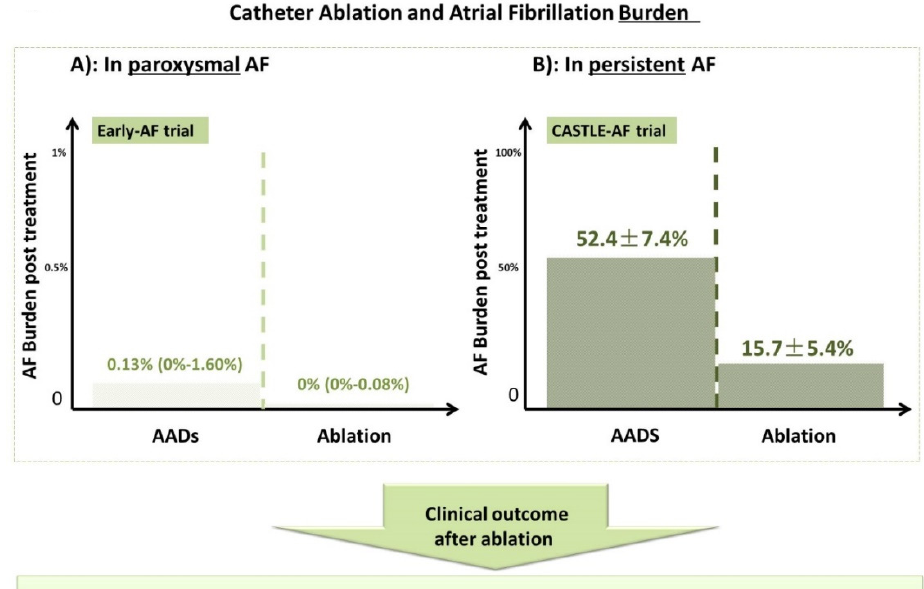
Figure 6. Catheter Ablation and Atrial Fibrillation Burden.